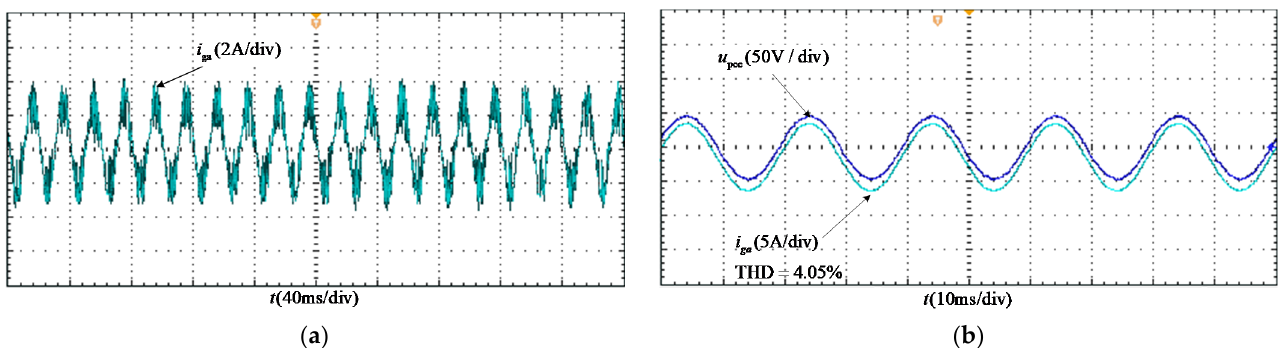
Figure 12. Experimental results under strong grid: ( a ) switching of delay compensation links; ( b ) network current and PCC voltage at steady state.